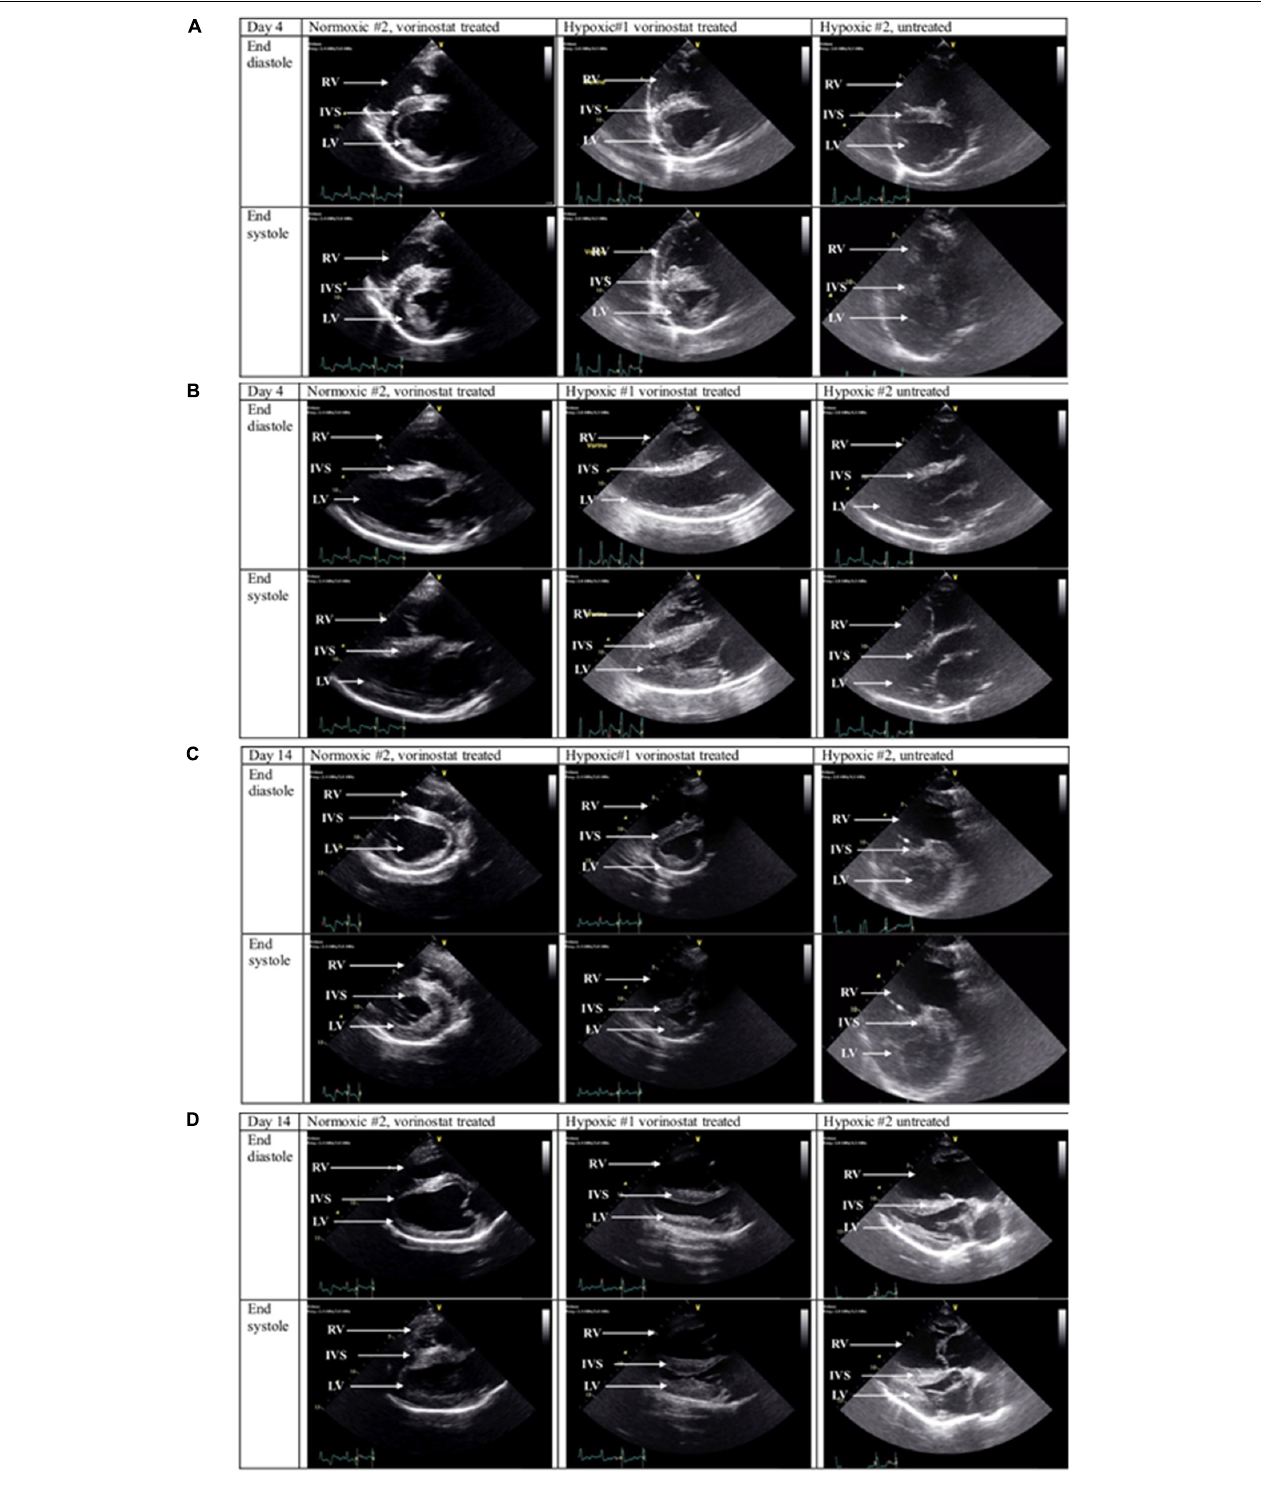
FIGURE 1 | Echocardiographic imaging of vorinostat effects in calves with hypoxia-induced pulmonary hypertension. Calf environmental exposures, vorinostat treatments, and echocardiography were performed as described in section “Materials and Methods.” Representative echo images captured at systole and diastole are shown for one normoxic vorinostat-treated calf, one hypoxic vorinostat-treated calf, and one hypoxic untreated calf. Note: Representative echo recordings of cinematic loops are shown in Supplementary Videos 1, 2 . (A) Experimental day 4, parasternal short axis views. (B) Experimental day 4, parasternal long axis views. (C) Experimental day 14, parasternal short axis views. (D) Experimental day 14, parasternal long axis views.